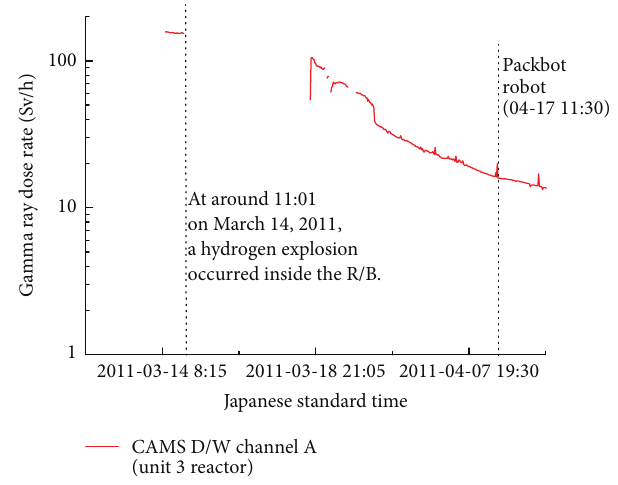
Figure 1: Gamma ray dose rates of the PCV D/W area in unit 3